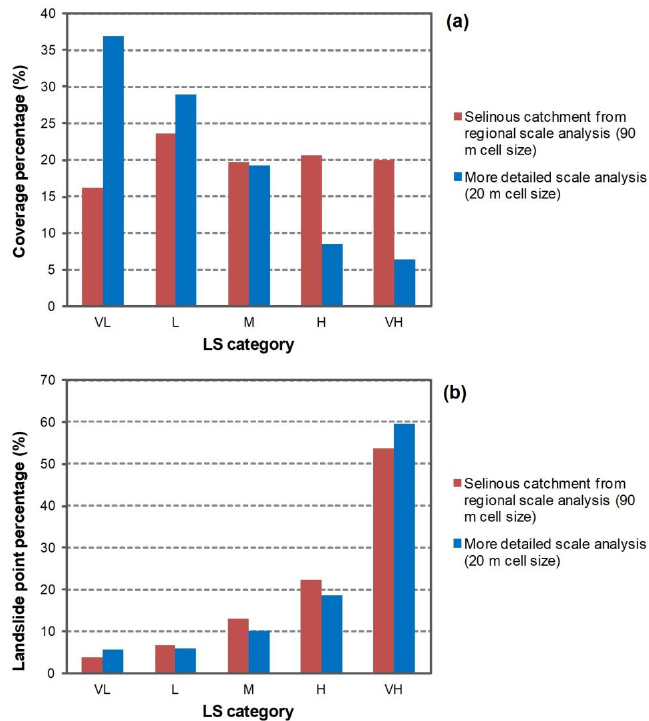
Figure 4. Diagrams with: ( a ) The coverage area percentages; and ( b ) the percentages of landslide points for landslide susceptibility categories (VL: Very Low, L: Low, M: Moderate, H: High, VH: Very High) derived from the two analyses focusing on the extent of Selinous catchment.